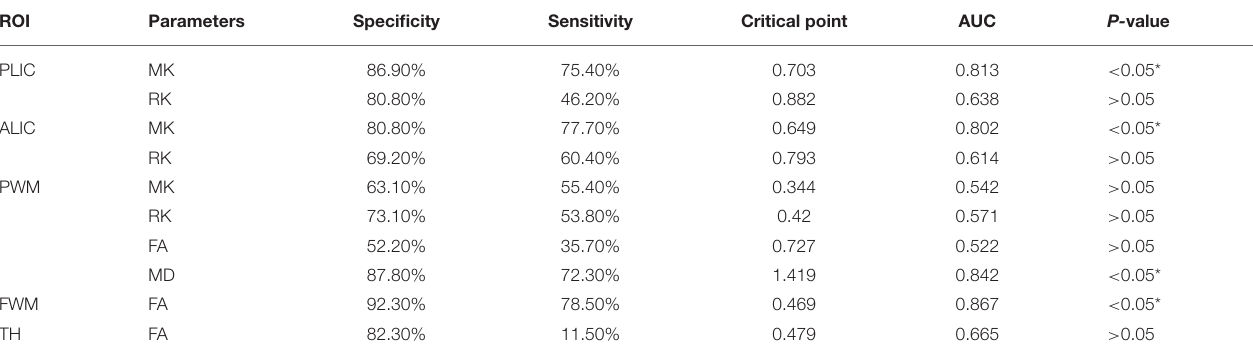
TABLE 3 | Diagnostic performance of DKI parameters in different ROIs. ROI